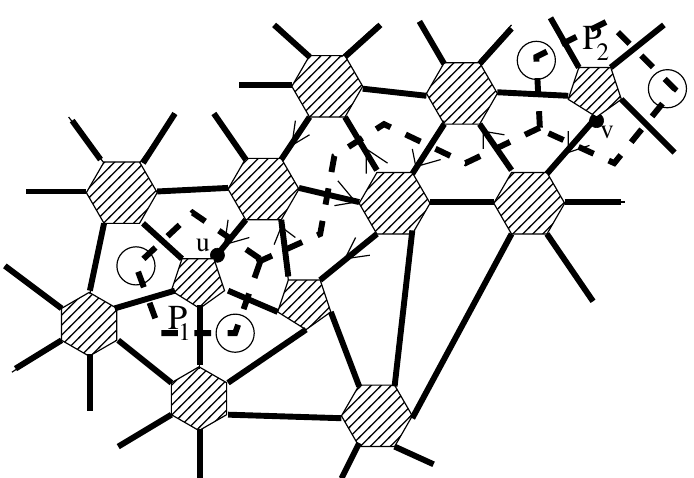
Figure 3. Any pair of close pentagons is nice.